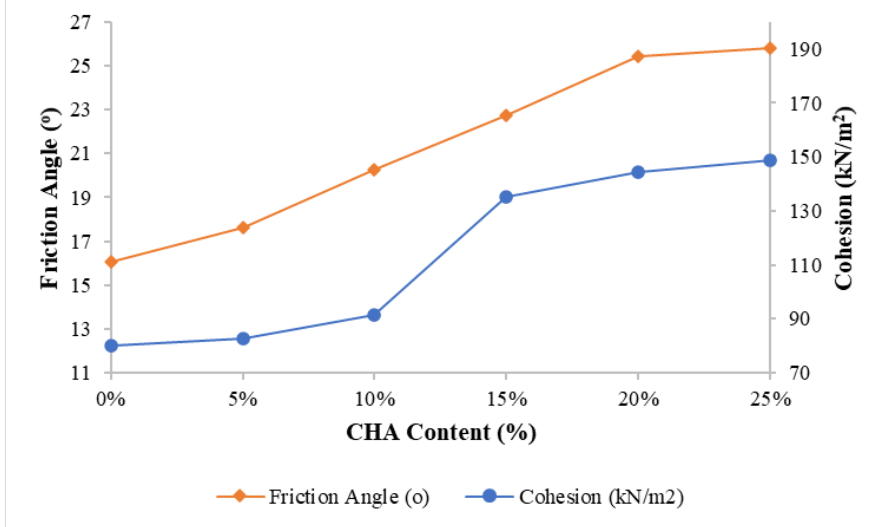
Figure 11. Shear strength of the soil – CHA mixture.